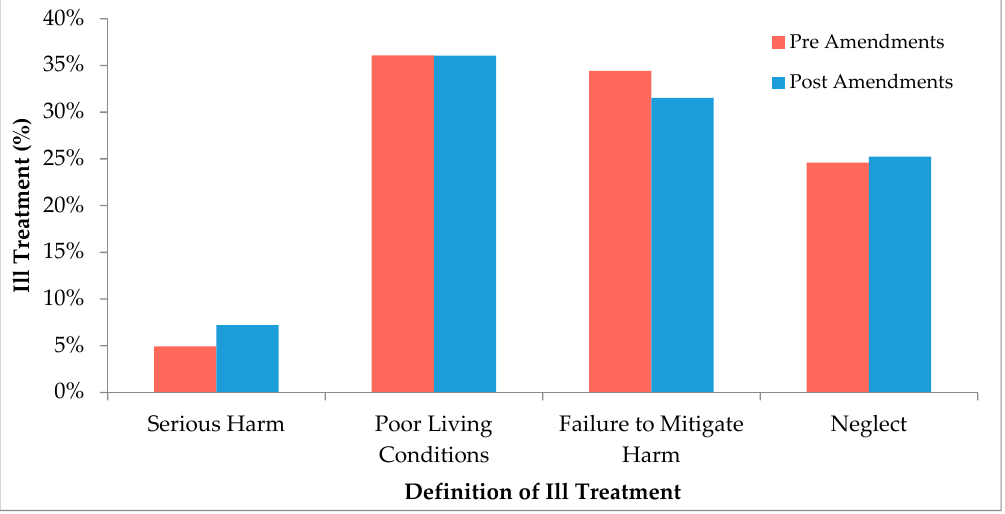
Figure 3. Comparison of the percentage of offences defined under section 13 of the AWA presented in courts before and after the 2008 amendments. Only the four most common definitions were considered and broken into pre-amendments ( n = 61) and post-amendments ( n = 222). Poor living conditions include failure to provide adequate food and water. Error bars are not included, as the data are presented as percentages; p -value = 0.50.